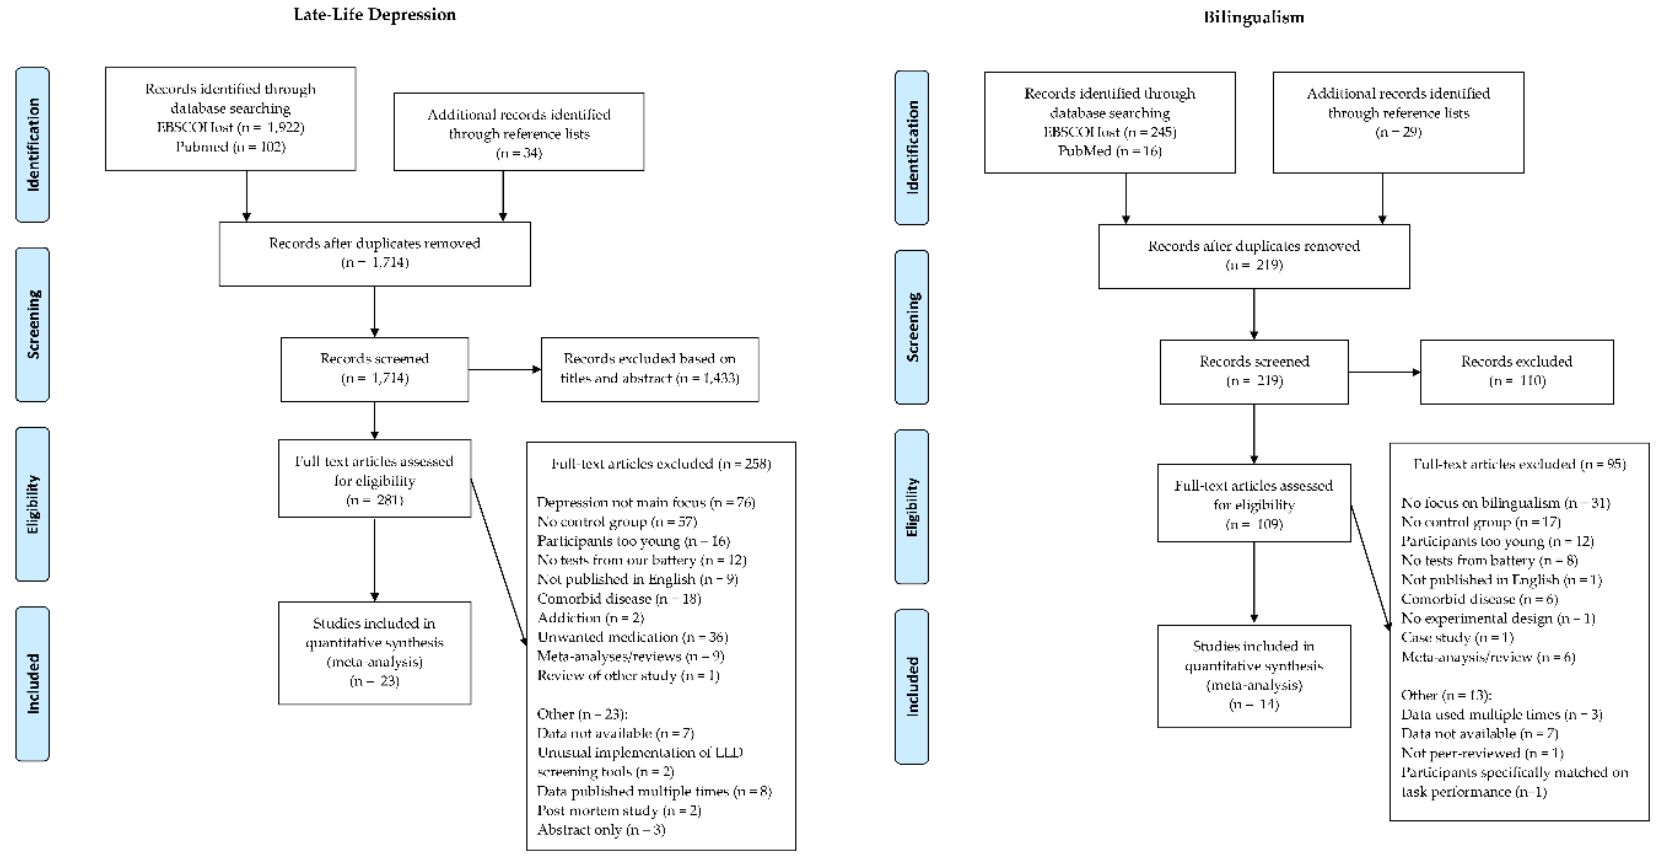
Figure 1. PRISMA flow diagram of the screening process for late-life depression (left) and bilingualism (right).